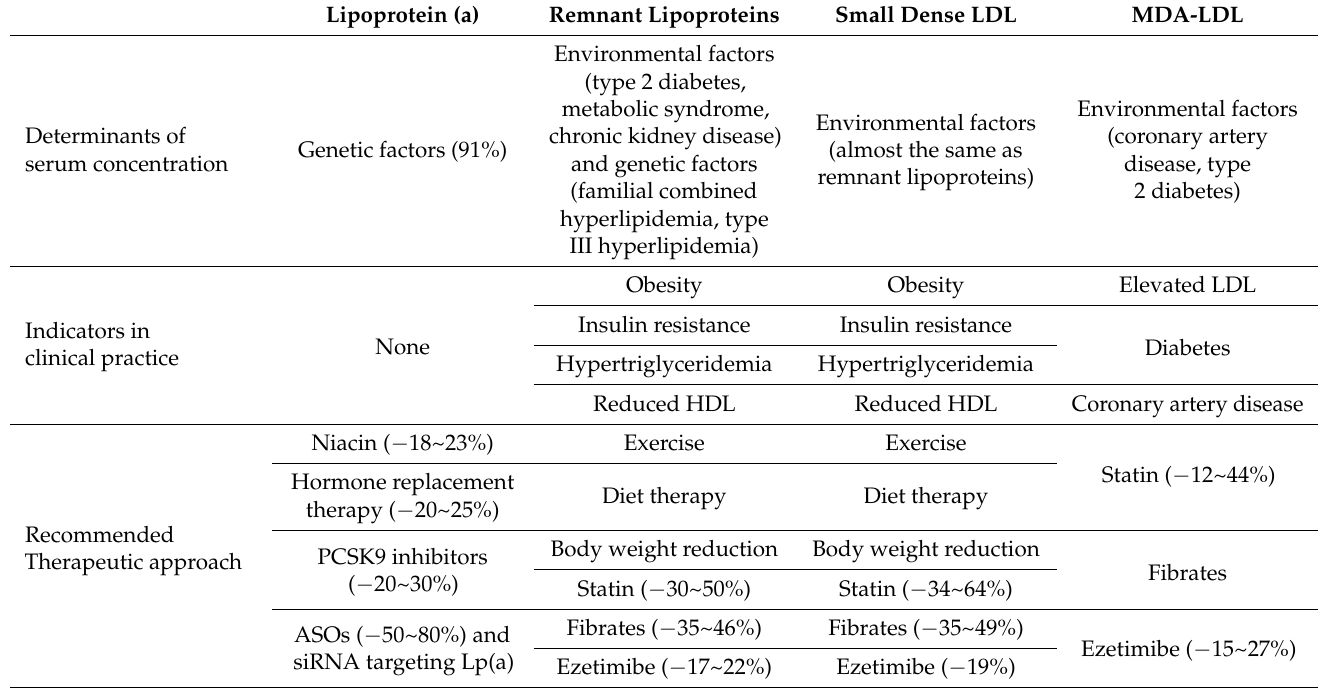
Table 1. Determinants of serum concentration, indicators in clinical practice, and recommended therapeutic approaches for elevation of lipoprotein (a), remnant lipoproteins, small-dense LDL, and MDA-LDL. Lipoprotein (a) Remnant Lipoproteins Small Dense LDL